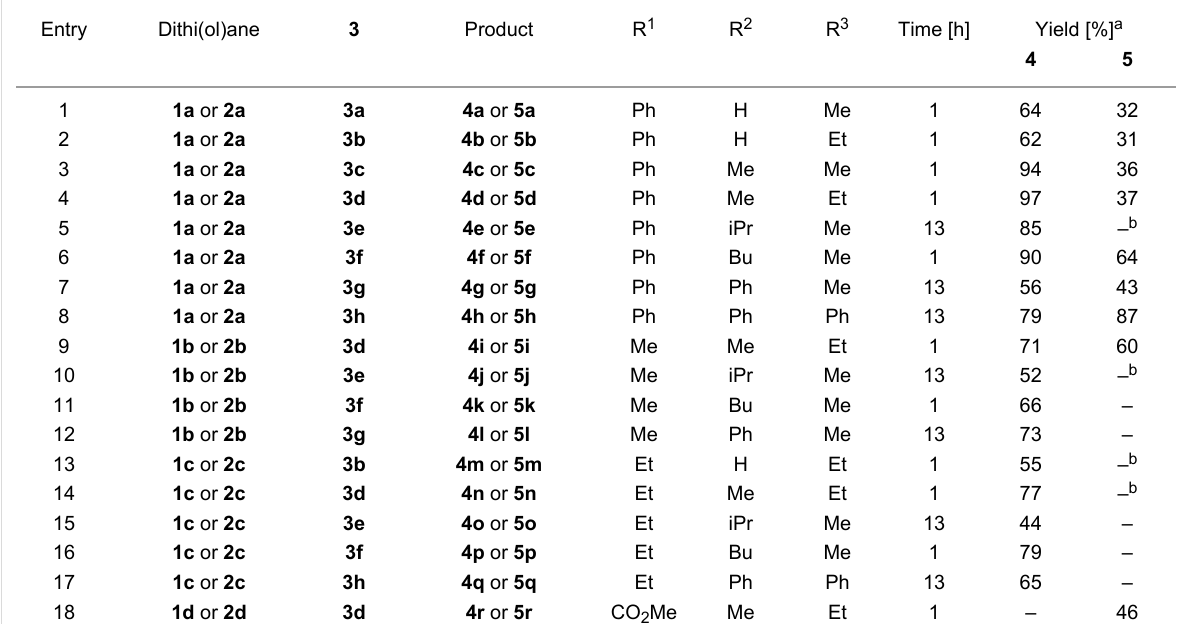
Table 1: Addition of dithi(ol)anylium TFBs 1a , 2a – 1d , 2d to ketones 3a – h